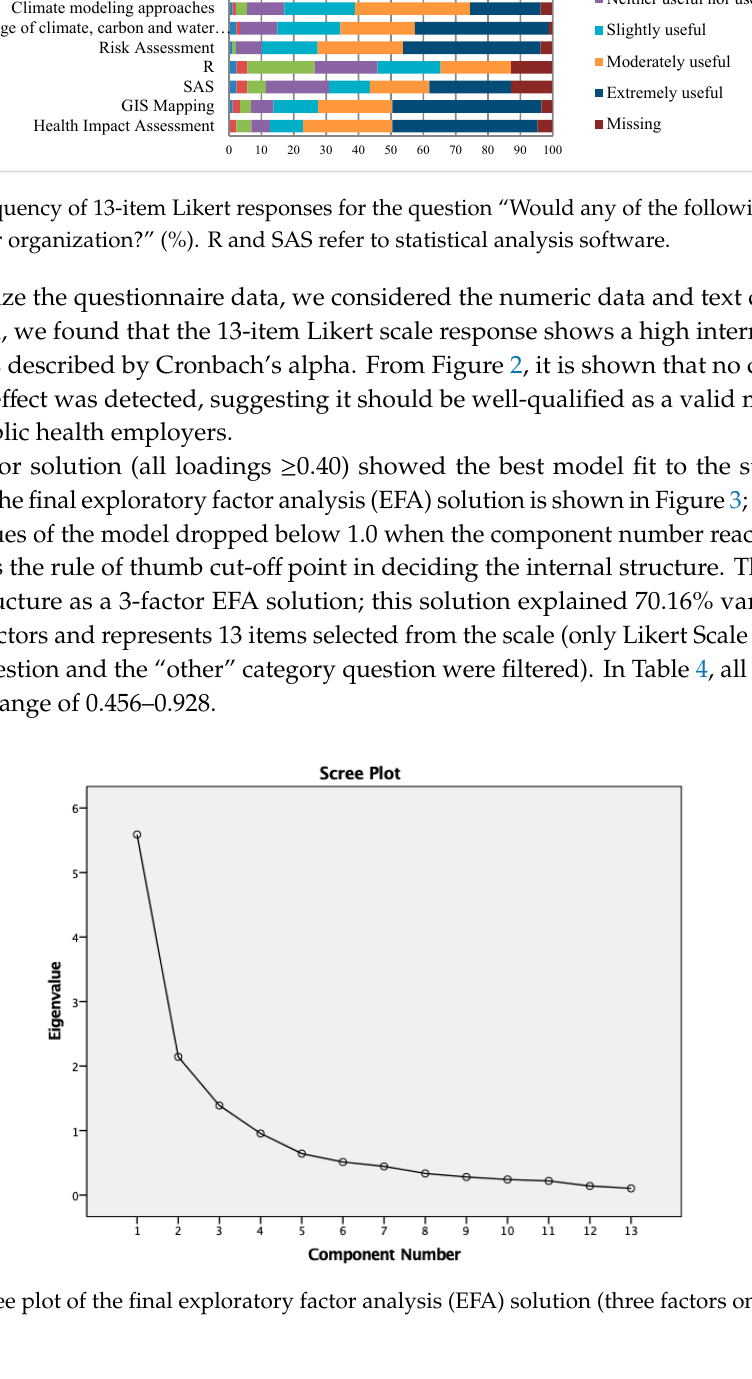
Table 5. Pattern matrix of the EFA solution (three factors, 13 items). Factor Item Would any of the following skills be useful to your organization? (%)